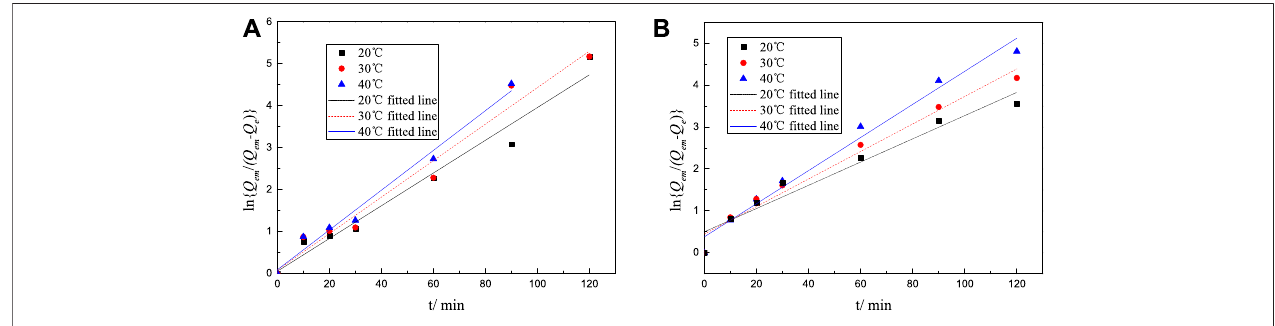
FIGURE 9 | Lagergren fi tted line of adsorption rate equation of M-PCE at cement particle surfaces at different temperatures: (A) M-PCE and (B) O-PCE.